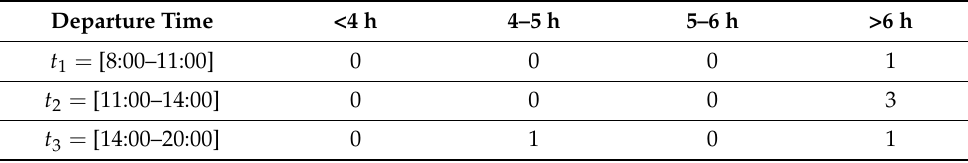
Table 6. Trains from Hangzhou to Beijing on 1 April